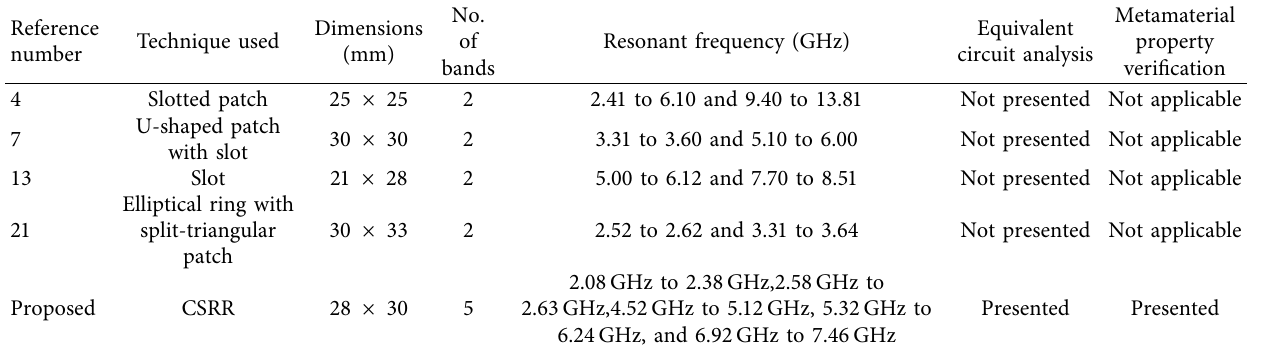
Table 4: Proposed antenna vs. literature